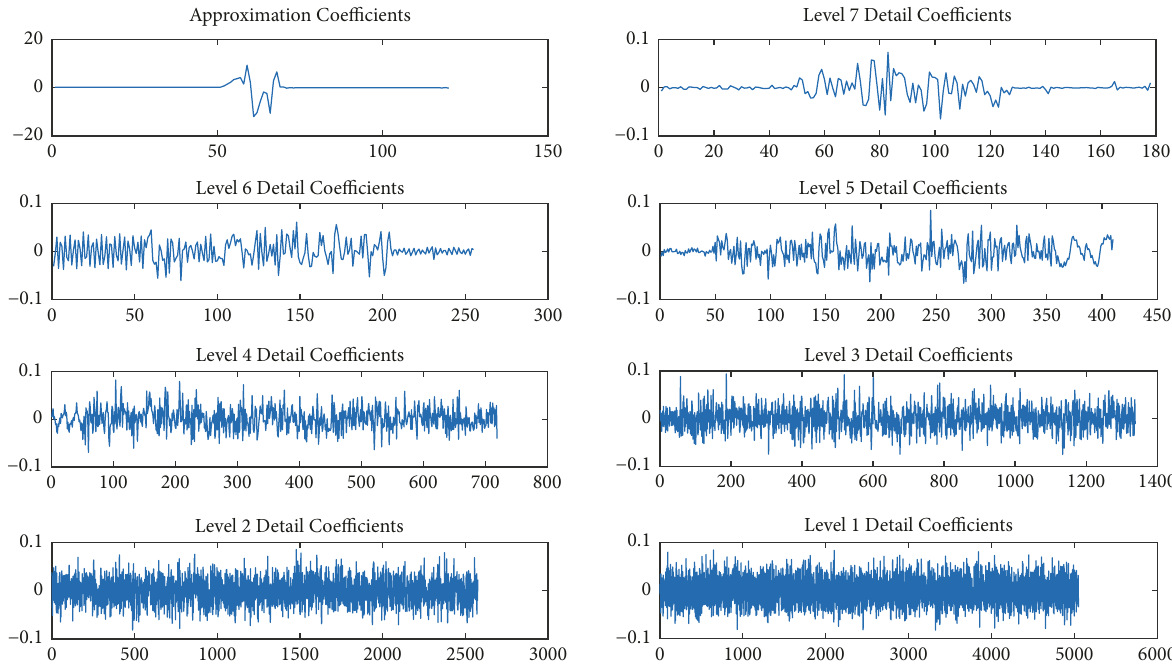
Figure 4: The wavelet coefficient distribution, the approximation and detail component.